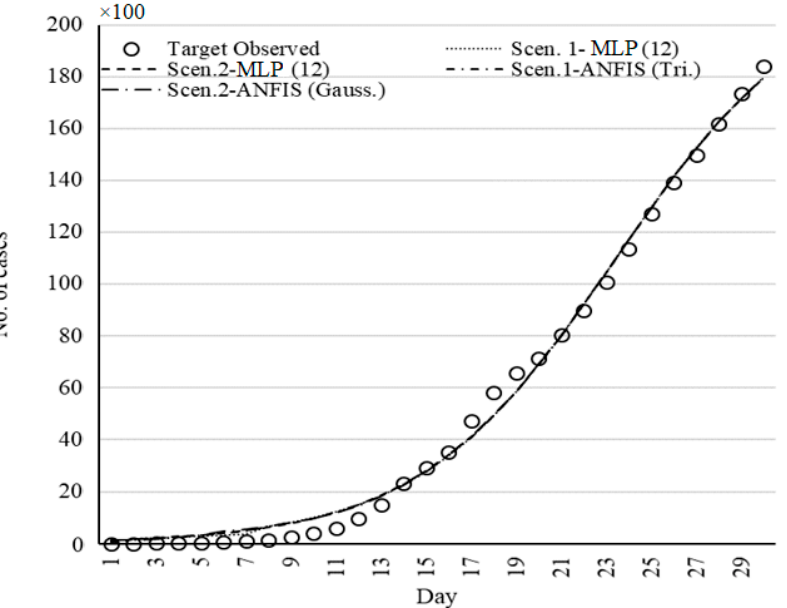
Figure 13. Set of models for China fitted by ML methods.